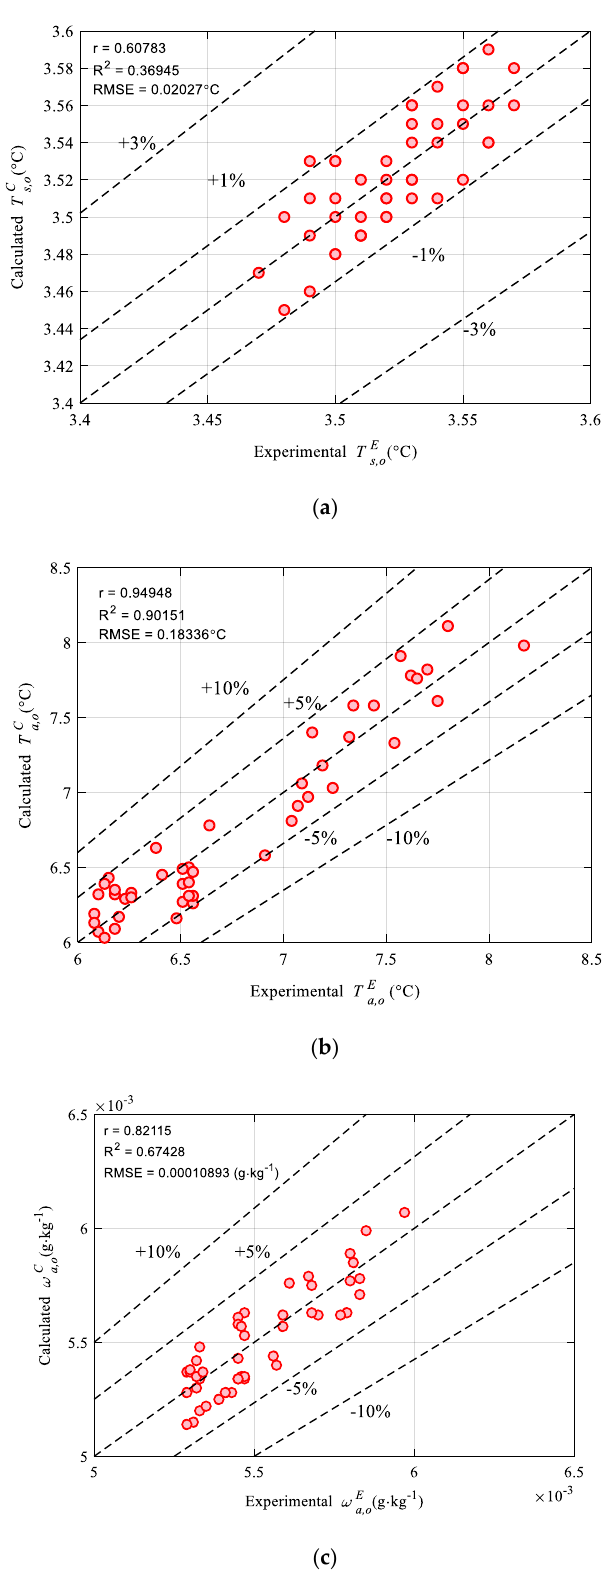
Figure7. Theexperimentaldatavs. thesimulateddataofcross-flowHST:( a )outletsolutiontemperature; ( b )outlet air temperature T a,o ; ( c )outlet air humidity ratio ω a,o